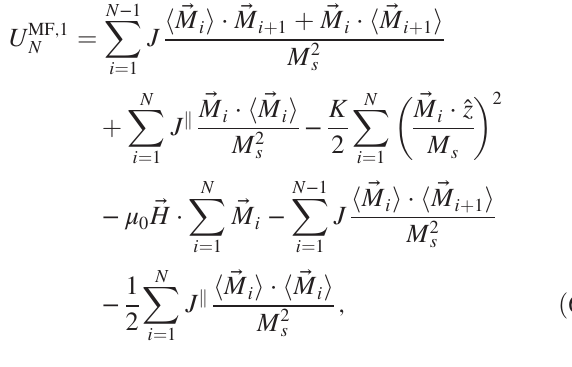
FIG. 4. Temperature-field phase diagrams of 2-SL and 3-SL MnBi 2 Te 4 . (a) Temperature-field phase diagram of 2-SL MnBi 2 Te 4 determined by MF methods, which is in coincidence with the RMCD measurements. The white circles and triangles represent the calculated spin-flop field μ 0 H 1 and spin-flip field μ 0 H 2 , respectively, at various temperatures, showing the boun- daries of the A-type AFM/CAFM phase and CAFM/FM phase. The experimental data points are represented using grey spheres and triangles with corresponding error bars. (b) Temperature-field phase diagram of 3-SL MnBi 2 Te 4 , showing the phase boundaries between the uncompensated A-type AFM/CAFM phase and CAFM/FM phase. The scale bar from pink to blue in both graphs shows the magnetization values of M=M from zero to s 3.0. The inset orange ( ↑ ) and green ( ↓ ) arrows denote the spin orientation of each